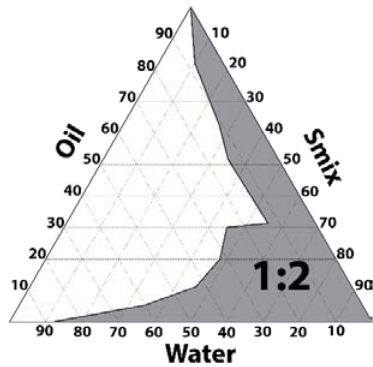
Figure 1. Pseudo-ternary phase diagrams: Capryol 90 (oil phase), Labrasol (surfactant), Transcutol-P (cosurfactant), and water (aqueous phase). Labrasol and Transcutol-P were mixed at the ratio 1:2 (w/w).